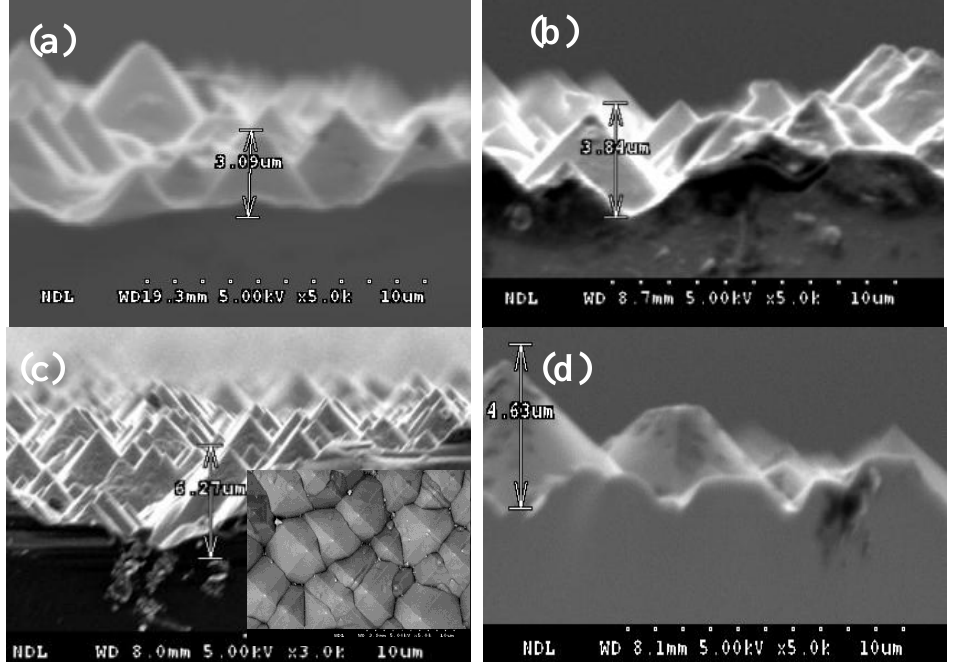
Figure 1. Cross-section images of the p-type Si(100) substrate after texturing at ( a ) 15, ( b ) 20, ( c ) 25 and ( d ) 30 min, respectively, were detected by scanning electron microscopy (SEM). The surface morphologies of the p-type Si(100) with the texturing time of 25 min are shown in the inset of